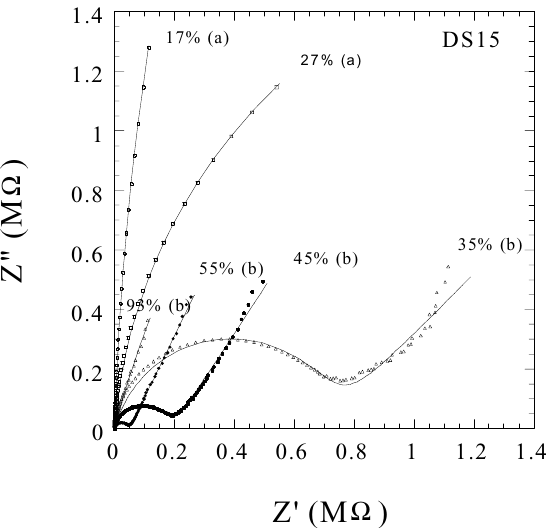
Figure 11. Cole-Cole plot of sensor DS15 at different humidity levels. The points represent the experimental data and lines the fit with the equivalent circuit model given in Figure 12. The RH values at which the data was collected and the equivalent circuit used for fitting each curve (given as (a) or (b) denoting the circuit of Figure 12a and 12b respectively) are shown adjacent to each